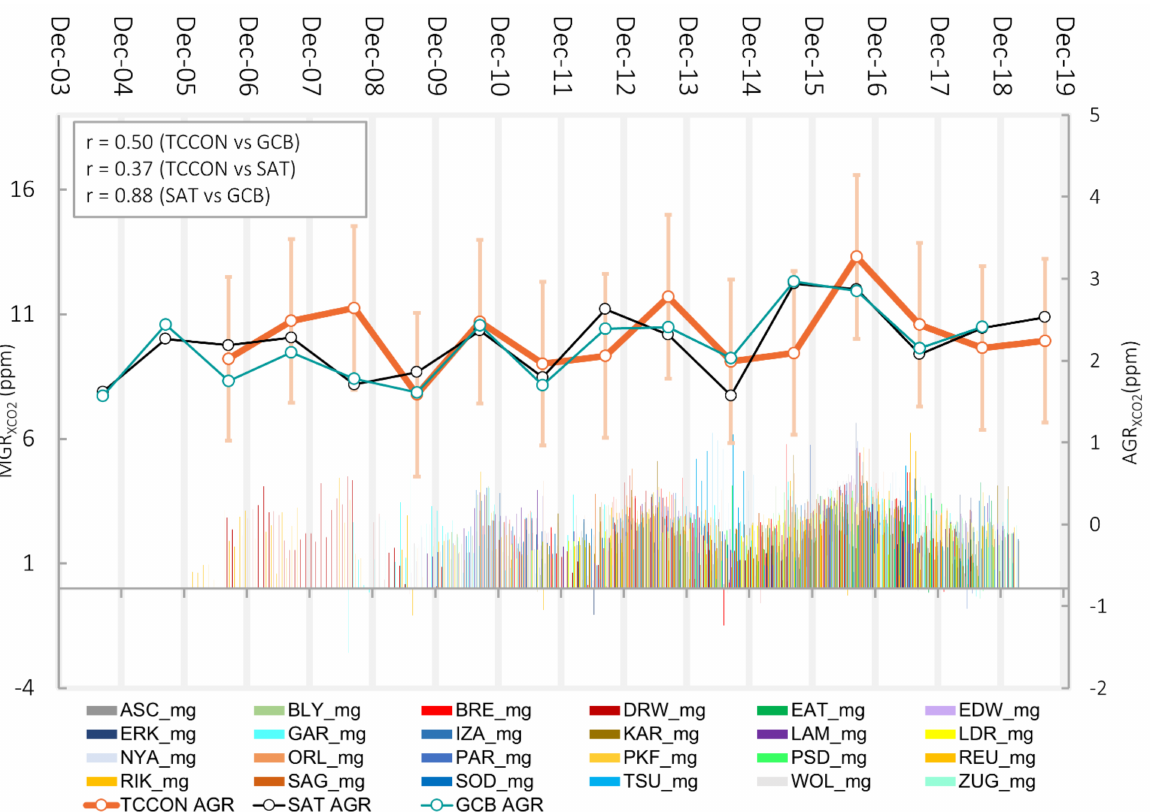
Figure 6. Lines represent the comparison of AGR TCCON (orange line) against AGR GCB (green line) and AGR SAT (black line) plotted versus August of each year (x-axis). Vertical thin bars stand for station-wise MGRs. Error bars of AGR TCCON (orange vertical dashed line) are defined based on the station-wise variability using method similar to Buchwitz et al. [8]. Mean √ standard deviation across TCCON stations (AGR), multiplied on N total /N factor (N-the number of stations used, N total -the total number of stations in TCCON analysis). Errorbars for AGR SAT and AGR GCB are omitted since their corresponding uncertainties are lower, and temporally less variable, than the uncertainties of AGR TCCON (0.20–0.36 ppm for SAT and 0.40 ppm for GCB). Bars represent MGR from all available TCCON sites (station name, ‘mg’ = MGR) during the study for simple visualizing the abundance of MGR data as input sources for AGR